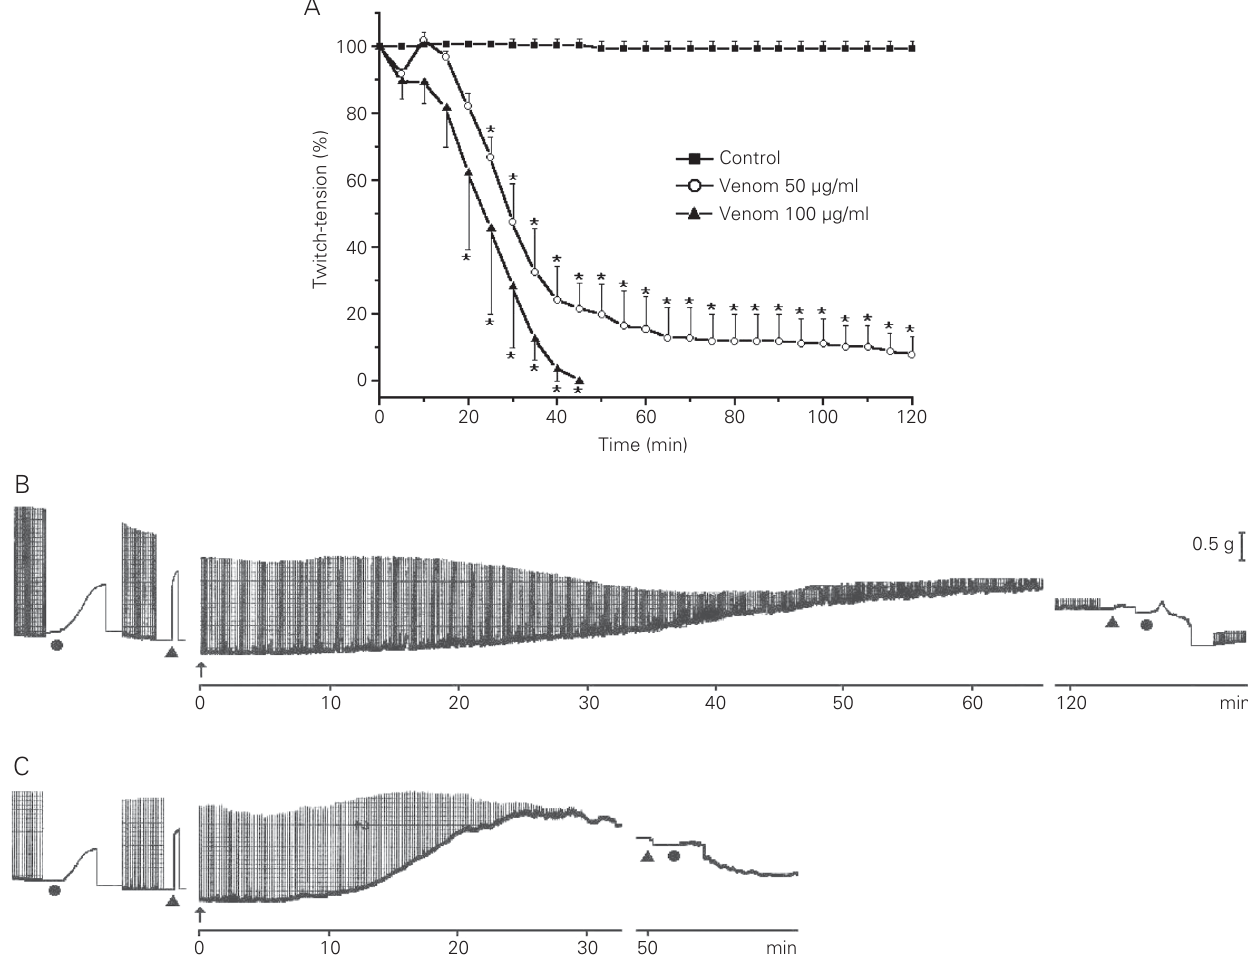
Figure 2. Effect of high concentrations (50-100 µg/ml) of Bothrops neuwiedii pauloensis venom on chick biventer cervicis preparations at 37 (cid:1) C. A , Concentration-time response curves for the neuromuscular blocking activity of the venom compared to Krebs solution alone (control). Each point represents the mean ± SEM of 3-6 experiments. B and C , Venom-treated preparations (50 and 100 µg/ml, respectively). B.n. pauloensis venom was added (arrow) after allowing the preparations to stabilize for 15 min. Note that the contractions induced by the venom were concentration dependent. The responses to exogenous 110 µM acetylcholine (triangles) and 13.4 mM KCl (circles) were obtained before and after the addition of venom. These results are representative of 3-4 experiments per venom concentration. *P<0.05 compared to the control preparations (Student t